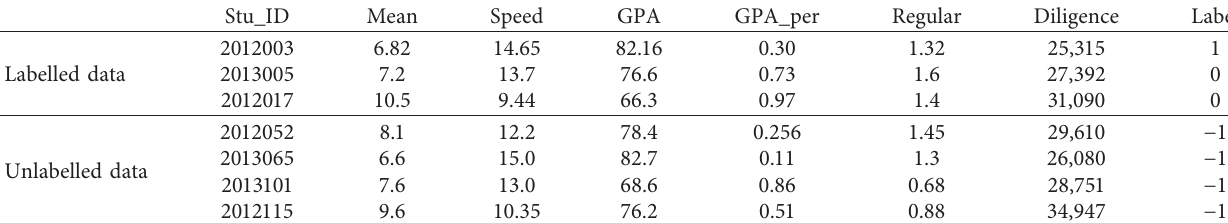
Table 8: The input data format of Algorithm